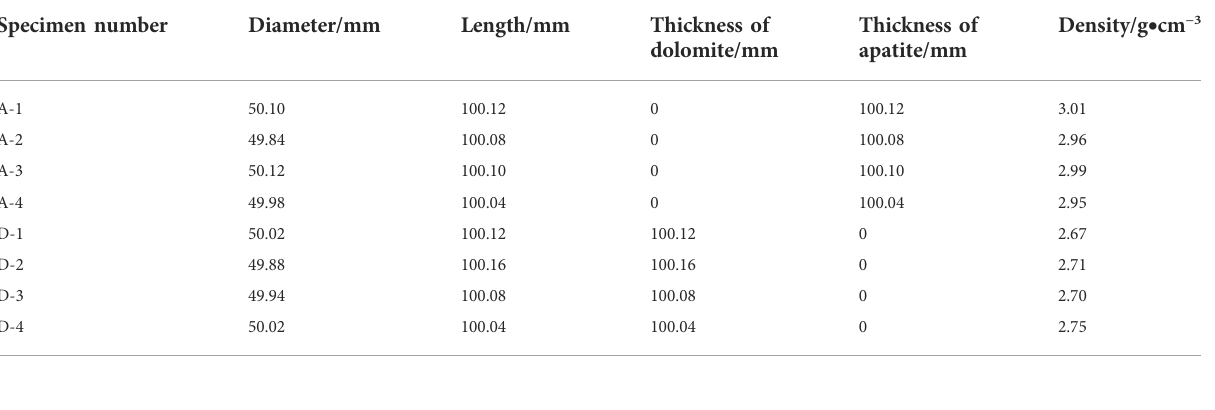
TABLE 1 Specimen dimensions and density for the rock-forming minerals.